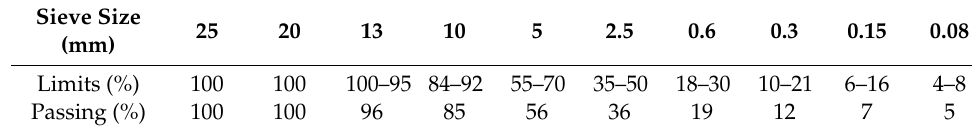
Table 2. Gradation of asphalt mixture.